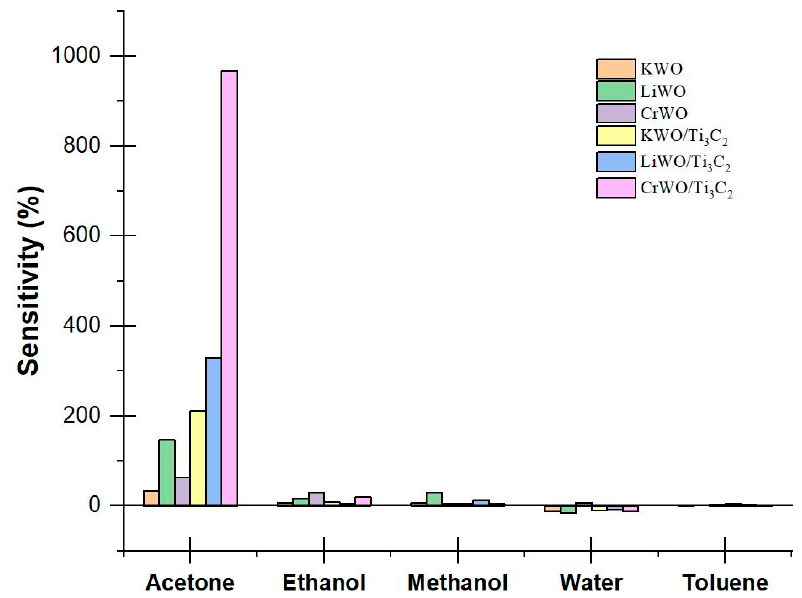
Figure 3. Selectivity data of various materials are shown. The vertical axis represents the sensitivity as defined in previous equations. The chemicals that were tested are shown on the horizontal